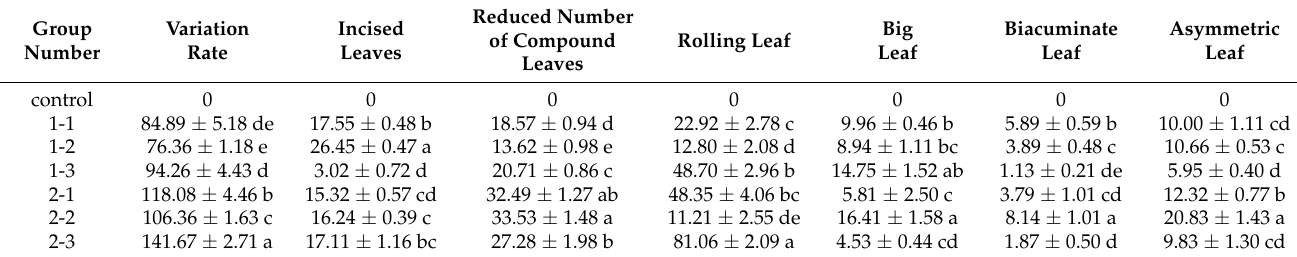
Table 1. Mutagenic effect of irradiation on leaf